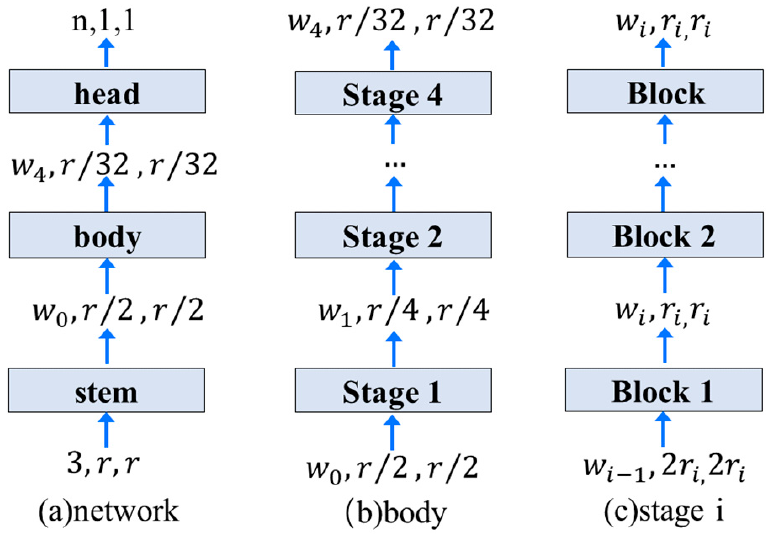
Figure 6. The design process of the architecture search space in this paper.